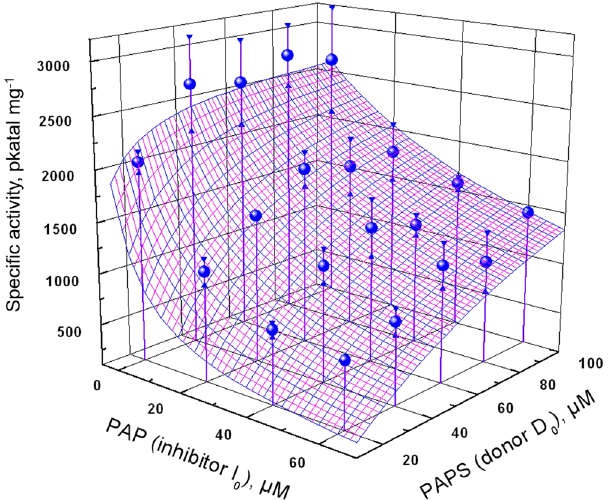
Figure 7. 3D plot of AtSOT18 kinetic titration data their fit. Blue spheres represent the mean values of three replicates of the enzyme rate in pkatal mg − 1 . Triangles are the estimated errors of experimental points. The wire frame surface represents the fitted function. Ds-3MTP concentration was kept constant at 60 µ